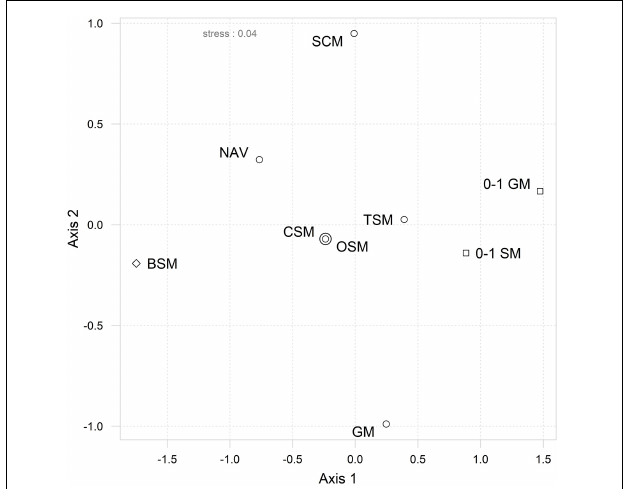
FIGURE 2 | Second-stage ordination by MDS of ranked inter-matrix pairwise Spearman rank correlations. Resemblance matrices included: Original (OSM), common (CSM), transformed (TSM) and Navicula species abundances matrices; species relative biovolume (BSM) and genera abundances